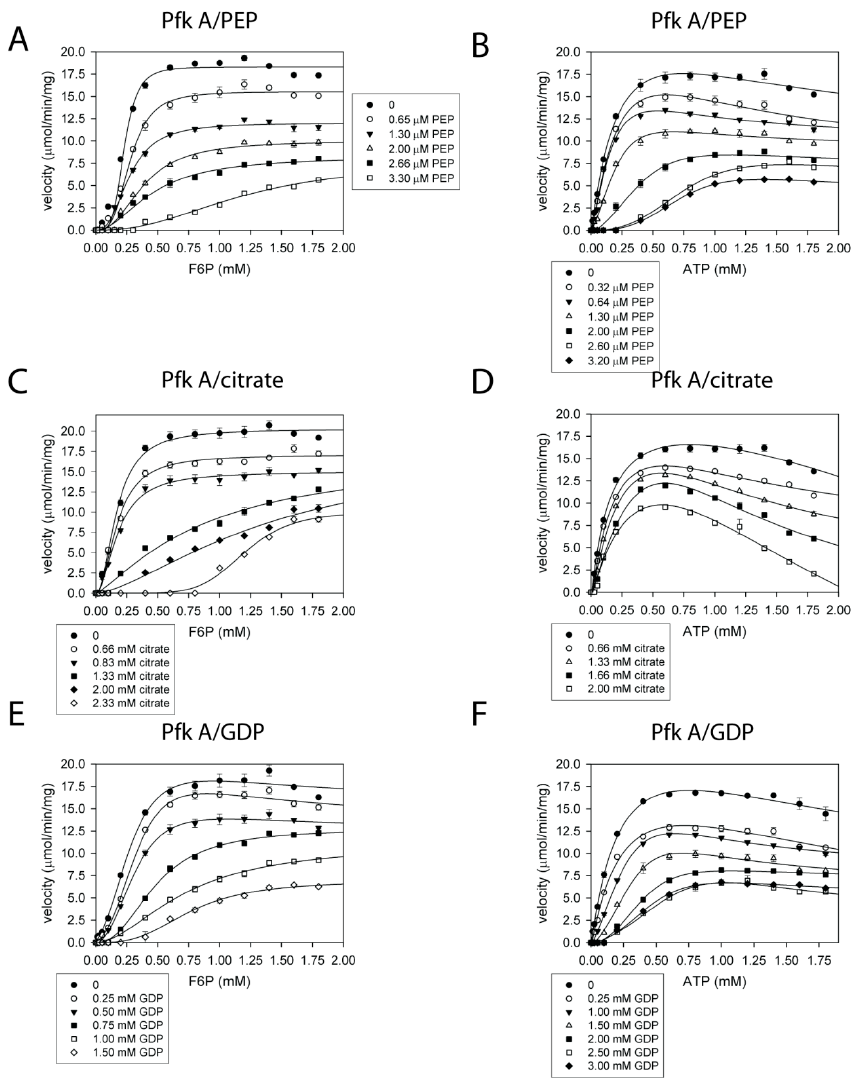
Figure 4. The inhibition of Pfk A by PEP ( A,B ), citrate ( C,D ), and GDP ( E,F ). Plots of the inhibitions with F6P varied and ATP fixed at 1 mM (left diagrams: A , C , E ) and the inhibitions with ATP varied and F6P fixed at 1 mM (right diagrams: B , D , F ). The data were fitted to Equations (2) and